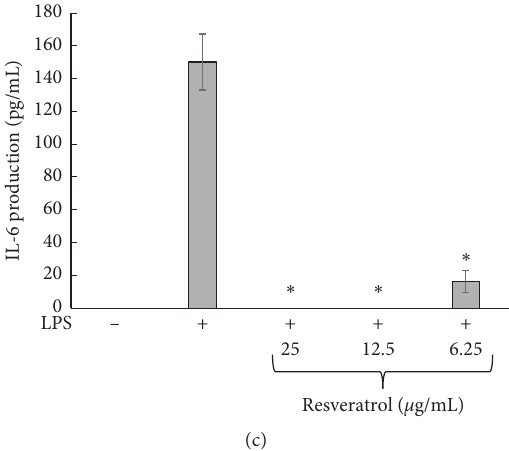
Figure 7: Effect of resveratrol on RAW264.7 cell viability (a), TNF- α production (b), and IL-6 production (c); ∗ p < 0 . 05 when compared with LPS-stimulated